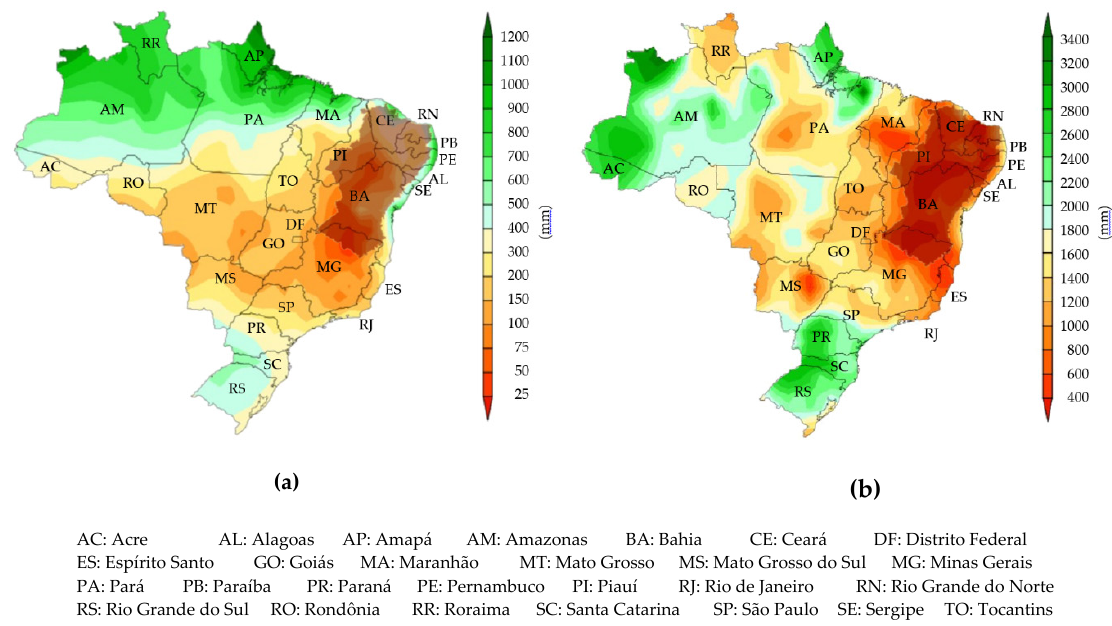
Figure 1. ( a ) Average rainfall in the early dry season (1981–2010); ( b ) total precipitation in 2015. Source: Adapted from Instituto Nacional de Meteorologia (INMET) [7]. The semiarid region (shaded in the Figure 1a,b) encompasses parts of the States of Alagoas, Bahia, Ceará, Minas Gerais, Paraíba, Pernambuco, Piauí, Sergipe, and the whole State of Rio Grande do Norte.